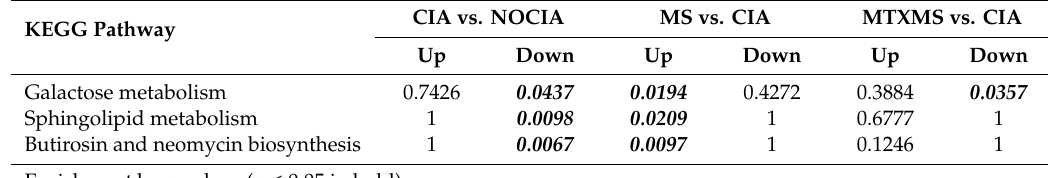
Table 1. KEGG pathways enriched by more and less abundant microbiome KEGG orthologies. KEGG Pathway